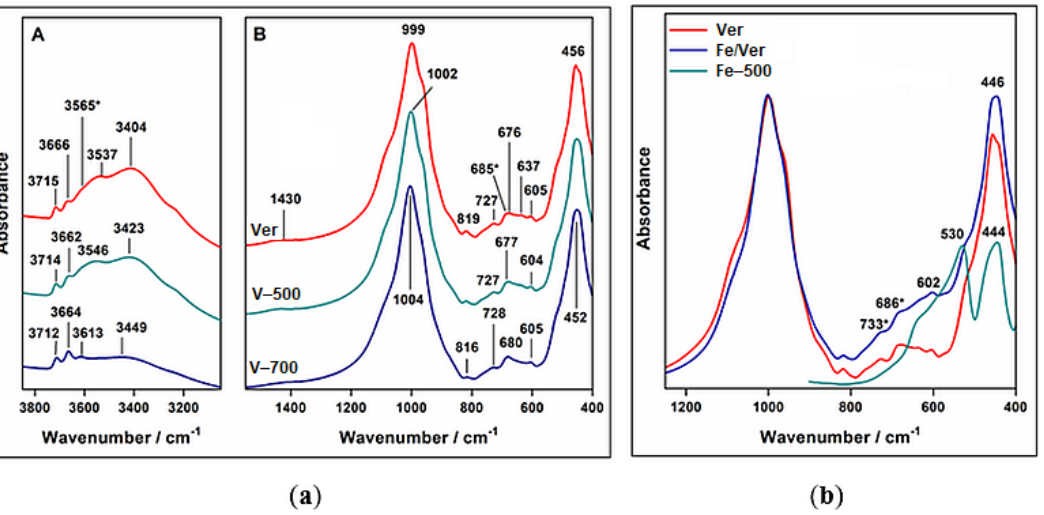
Figure 3. IR spectra of: ( a ) vermiculite (Ver) and samples heated at 500 ◦ C (V–500) and 700 ◦ C (V–700), ( A )–OH stretching region; ( B )–Si-O and OH bending region. * indicates the position obtained by the second derivative operation and ( b ) Ver, Fe/Ver and Fe–500.